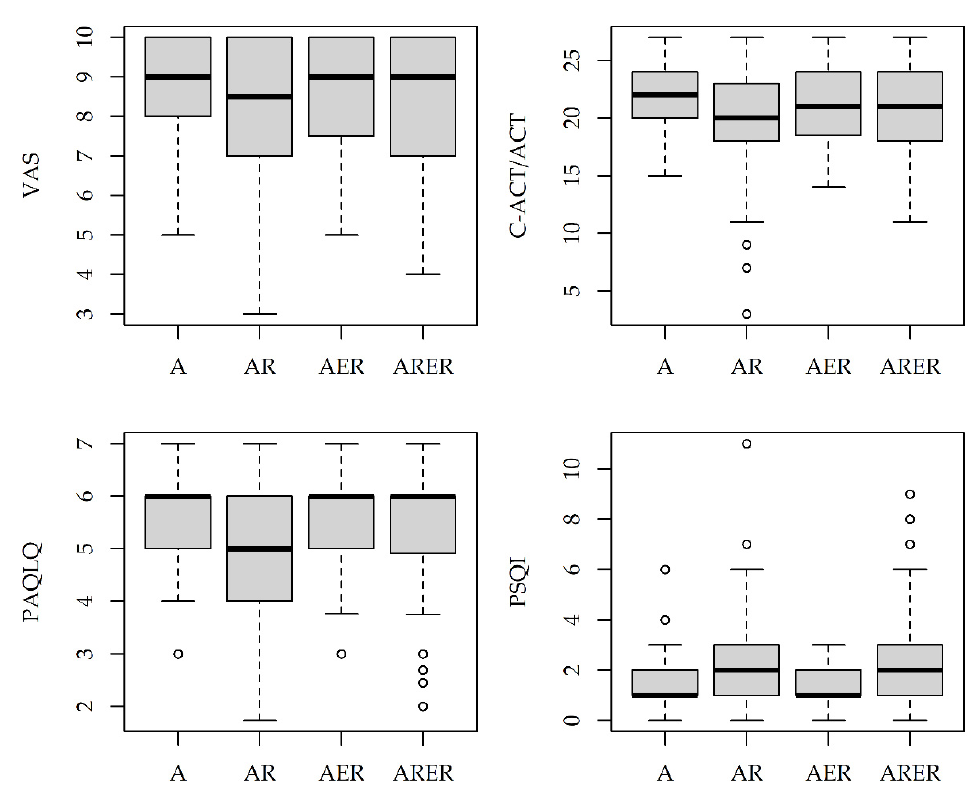
Figure 3. Distribution of VAS, CACT/ACT, PAQLQ, and PSQI scores by group in 225 children/adolescents who completed the questionnaires. Boxplots represent the median (central line), 25th–75th percentiles (box), and min-max non-outlier values (whiskers). A: asthma only. AR: asthma with respiratory comorbidities. AER: asthma with extra-respiratory comorbidities. ARER: asthma with both respiratory and extra-respiratory